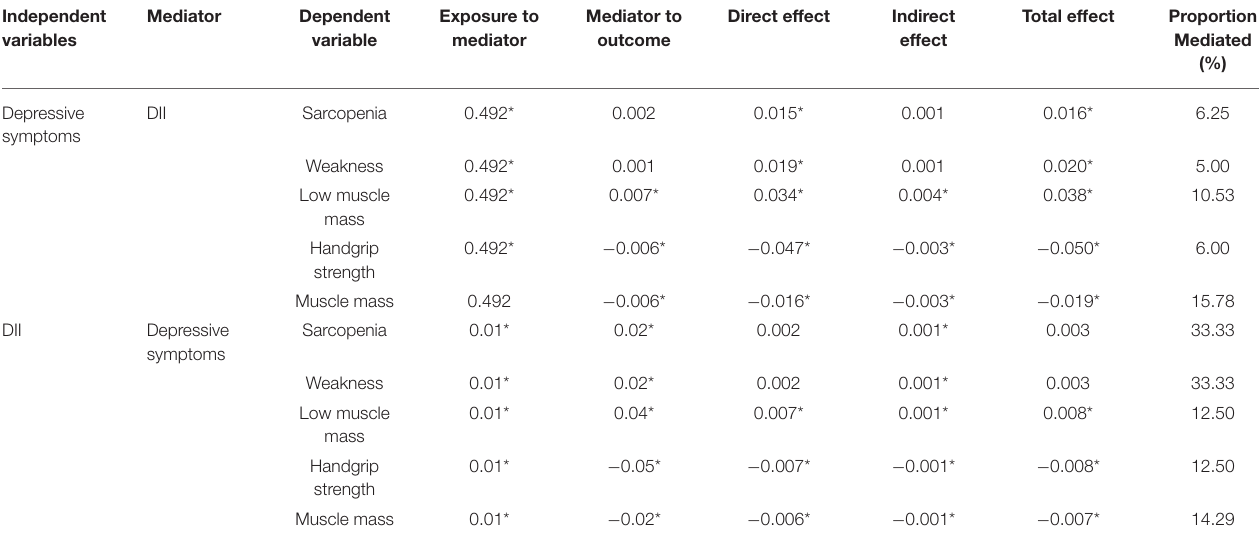
TABLE 4 | Mediation pathways among depressive symptoms, DII, and